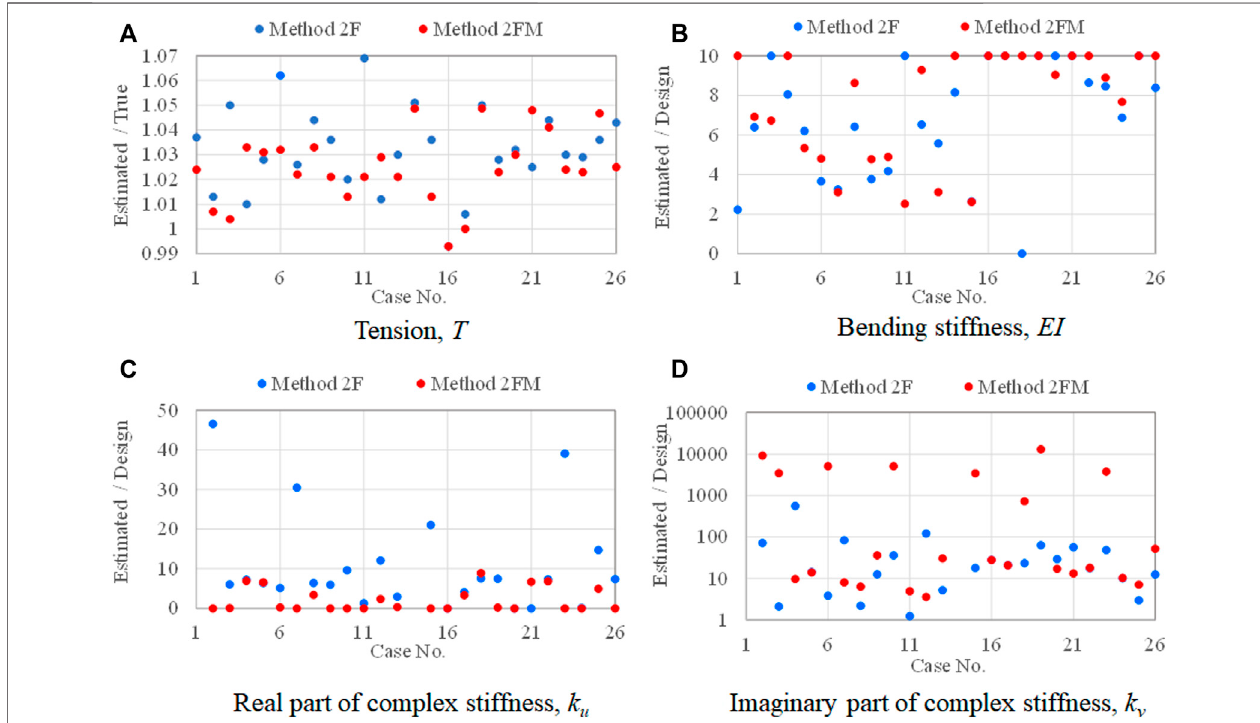
FIGURE9| Estimationresultsobtainedbyexperiments: (A) tension, T ; (B) bendingstiffness, EI ; (C) realpartofcomplexstiffness, k u ; (D) imaginarypartofcomplex stiffness.